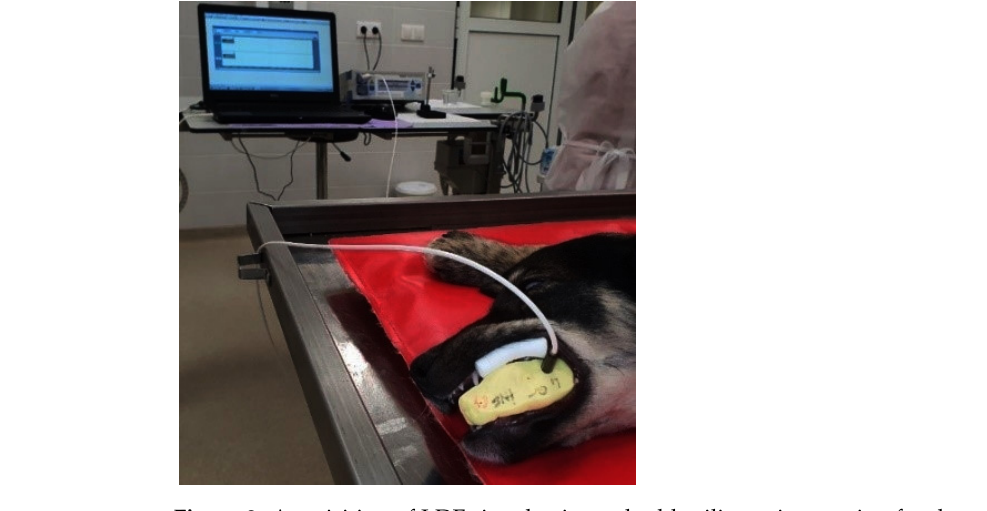
Figure 2. Acquisition of LDF signal using a double silicone impression for the stabilization of the probe and liquid rubber dam for the isolation of the pulpal signal from the periodontal contaminat- ing signal.